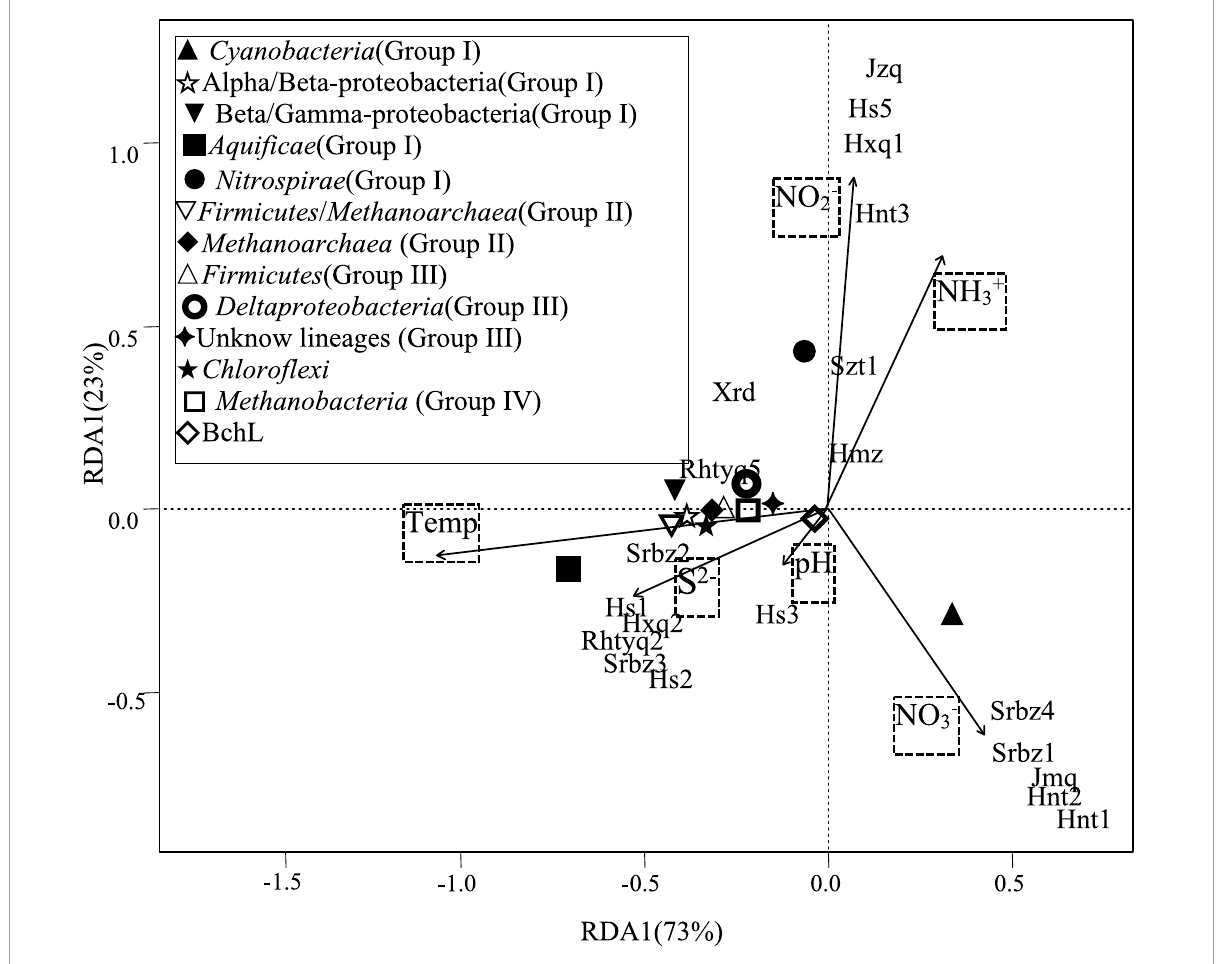
FIGURE4 RDA of phylogenetic lineages of nifH gene in relation to physicochemical variables. The percent variability explained by each principal component is shown in parentheses in the axis